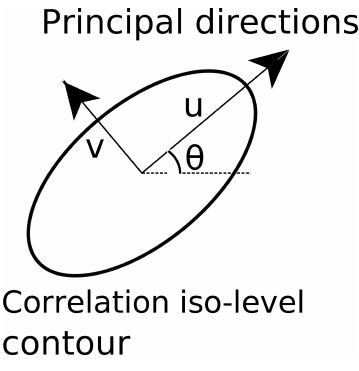
Figure 1. Representation of a generic ellipse that represents the geo- statistical geometric anisotropy of a wind or wave field. Supposing u and v are the two principal directions of anisotropy, the anisotropy > 1; symbol θ is the rotation angle of the ratio is R = u v